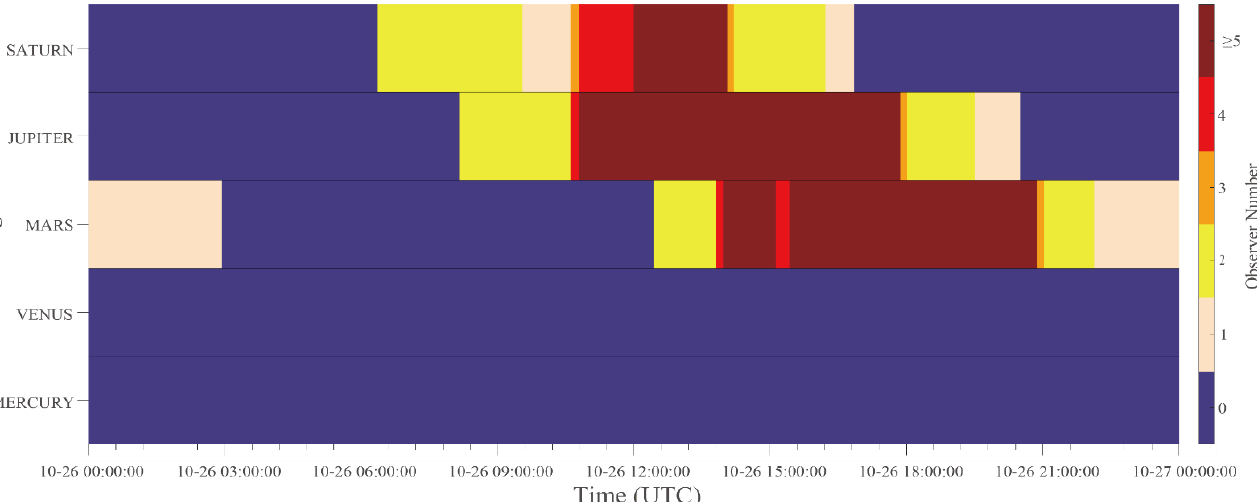
Figure 12. Observation windows for seven observatories and joint observation (noted as CO-OBS) for observing Mars on 26 October 2022. Colormap for single observatory indicates OBW . CO-OBS indicates the number of observers available simultaneously.